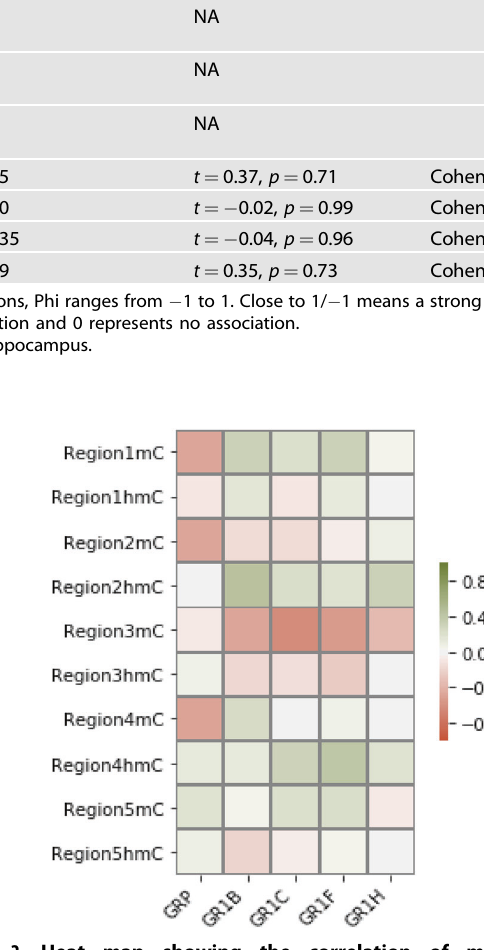
Fig. 2 Heat map showing the correlation of methylation, hydroxymethylation, and expression of GR CpG island. Heat map represents the fi ve regions (R1 – R5) analyzed for changes in % 5mC and %5hmC levels with expression data of GR-P and GR-1 variants (B – H). Red cells signify an increase in 5mC and down- regulated expression, green cells signify an increase in 5hmC and up-regulated expression. Correlation analysis was performed using Pearson ’ s correlation based on %5mC, %5hmC values, and fold change in log 2 values of gene expression